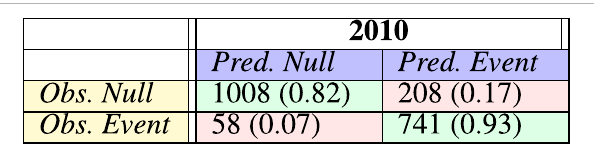
Frontiers in Astronomy and Space Sciences |